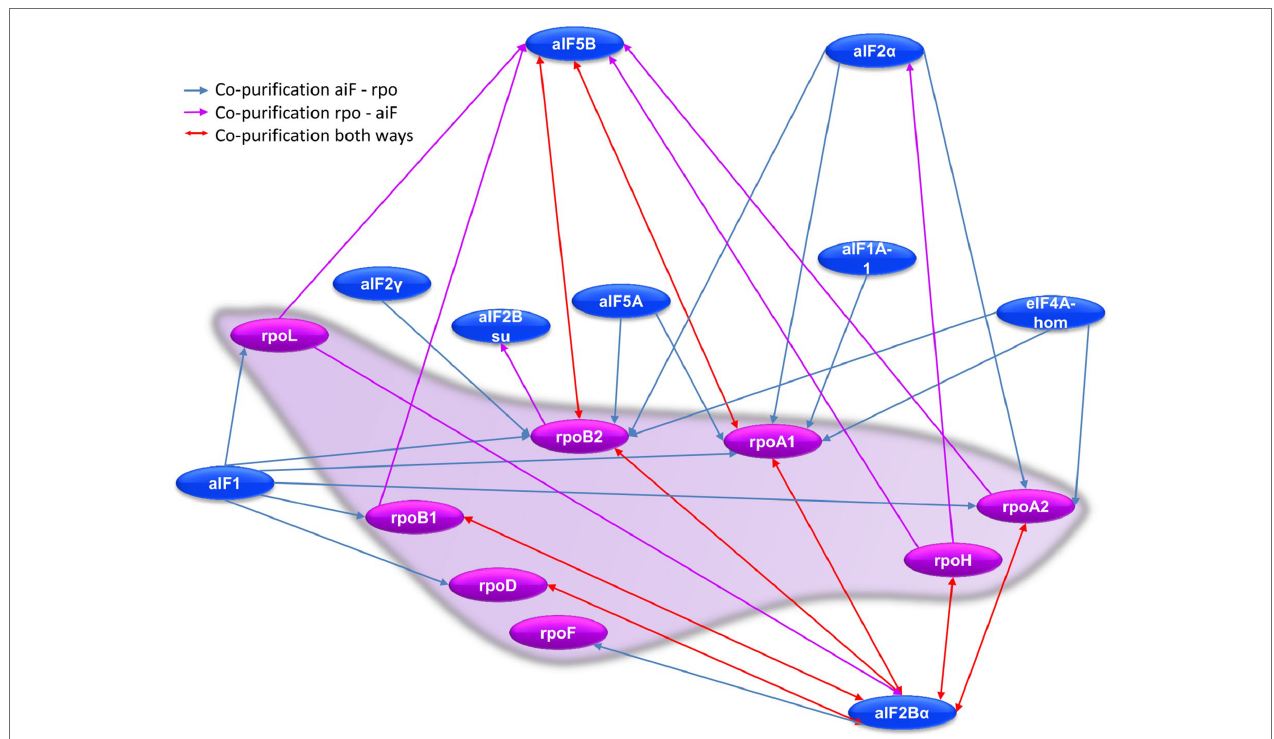
FIGURE 8 | Schematic overview of the RNA polymerase subunit–aIF interaction network. Red arrows denote reciprocal co-purification, blue arrows indicate co- purification of a Rpo subunit with a tagged aIF bait, while purple arrows indicated co-purification of an aIF with a tagged Rpo subunit as